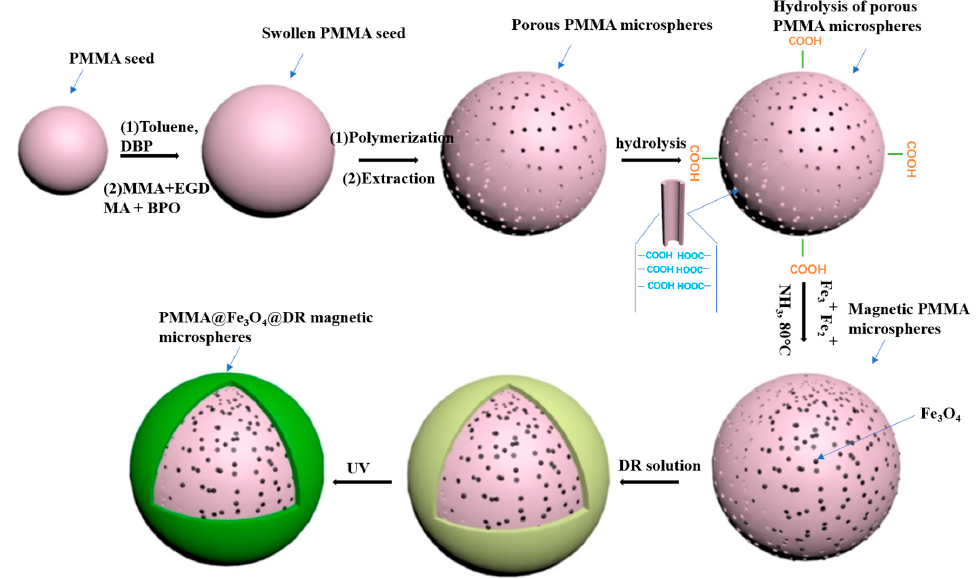
Figure 1. Schematic illustration of the synthesis process used to fabricate (polymethylmethacrylate)